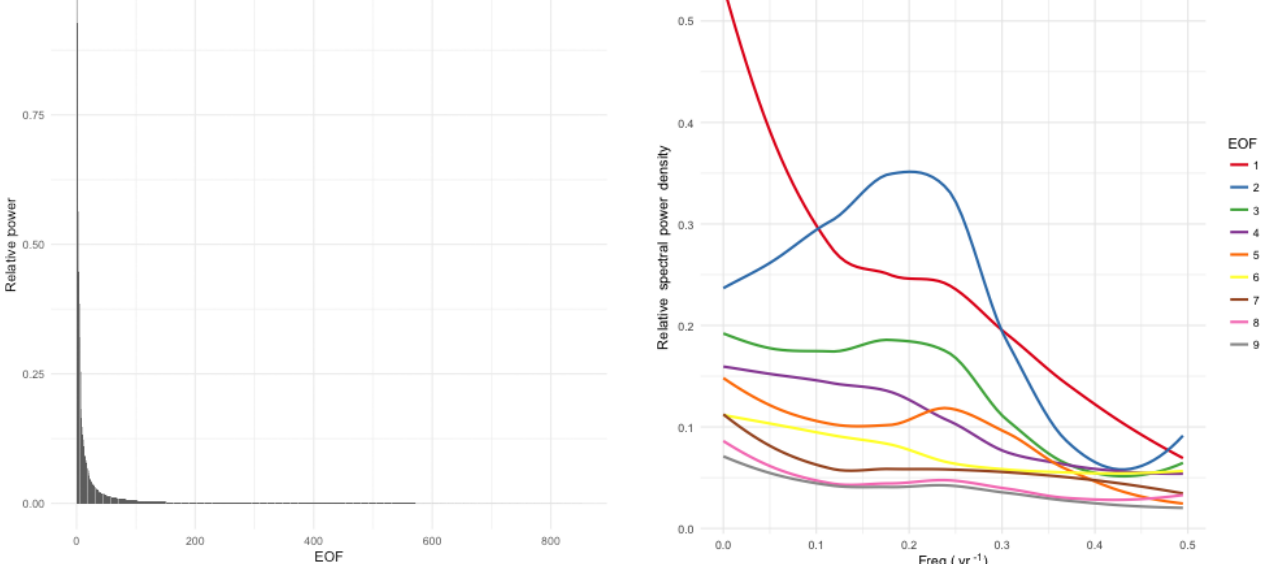
Figure 5. Smoothed power spectral density (PSD) for the first nine EOF basis functions. EOFs 2, 3, and 5 show peaks in the PSD, in- dicating quasiperiodic behavior on 3–5-year timescales. EOF 1 has most of its power at low frequencies, indicating that this component is approximately (though not exactly) constant over the course of a single ESM